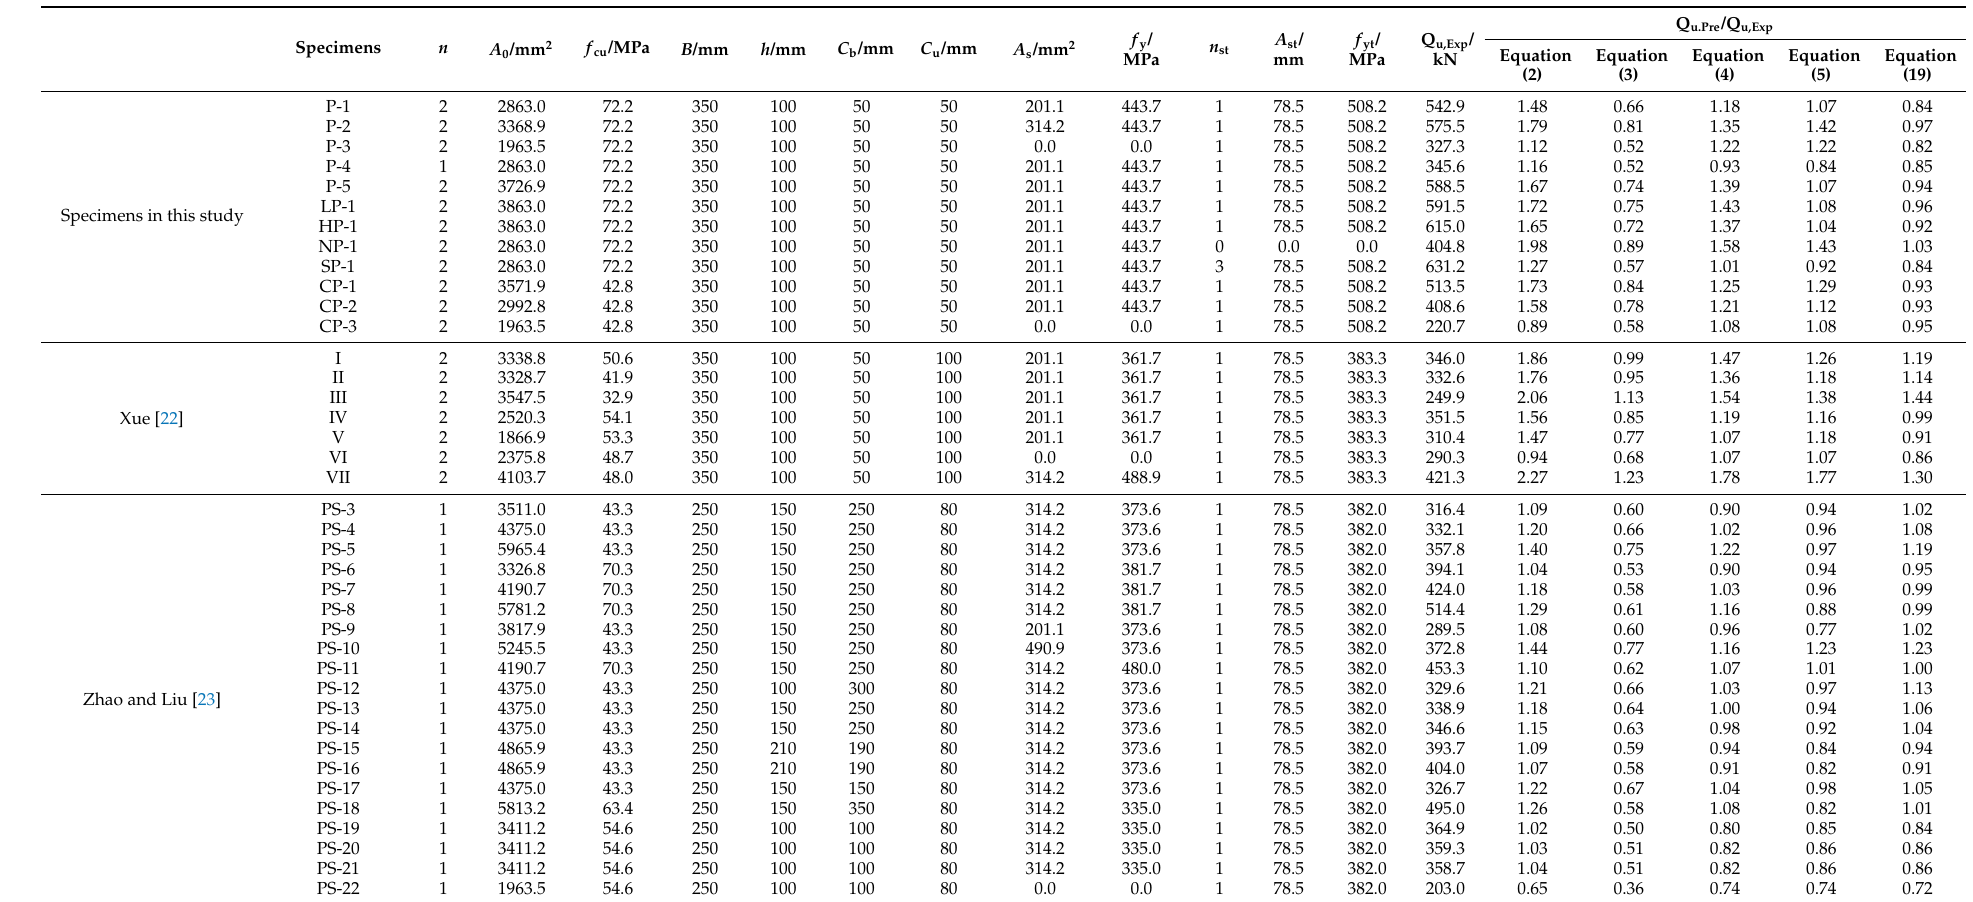
Table 5. Comparison of equations to predict the shear